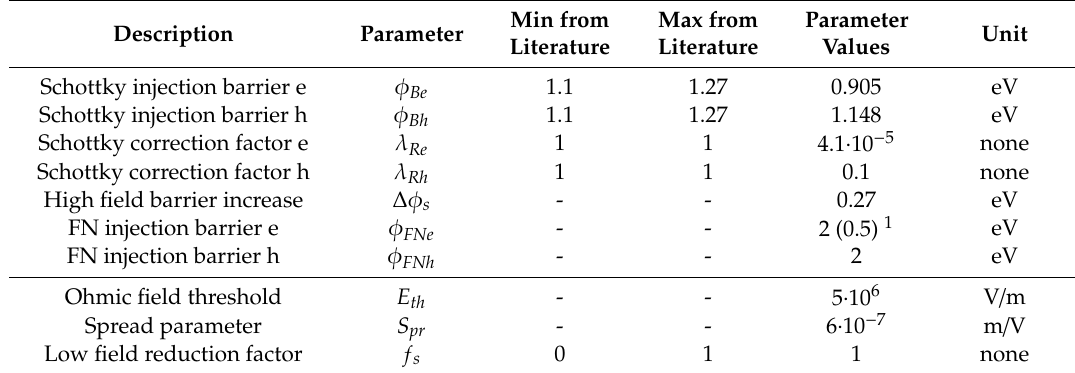
Table 2. Ranges of parameters for charge injection from [3–11] and magnitudes used in the model.